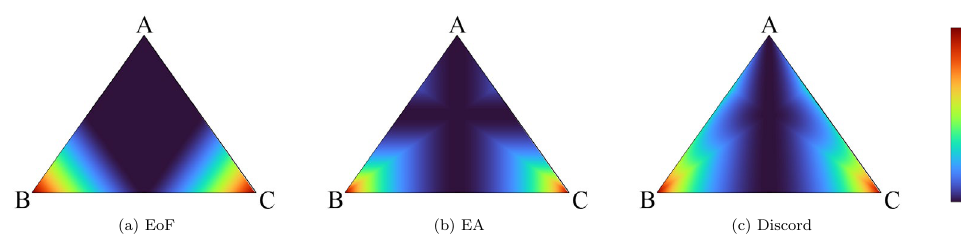
Figure 8. Strength of correlations on the plane formed by the convex combination of maximally entangled bell ψ )/ 2 , B and C are the other Bell states. The states depicted in Fig. 6d are lines states and face states. A is (φ − + + along one such plane. ( a – c ) Represent EoF, EA and discord respectively. EoF vanishes in the separable region whereas EA and discord are still non-zero for some states in the separable region. The surface plots are also indicative of the hierarchy these measures follow. EoF must be zero when EA is zero, and EA must be zero when discord is